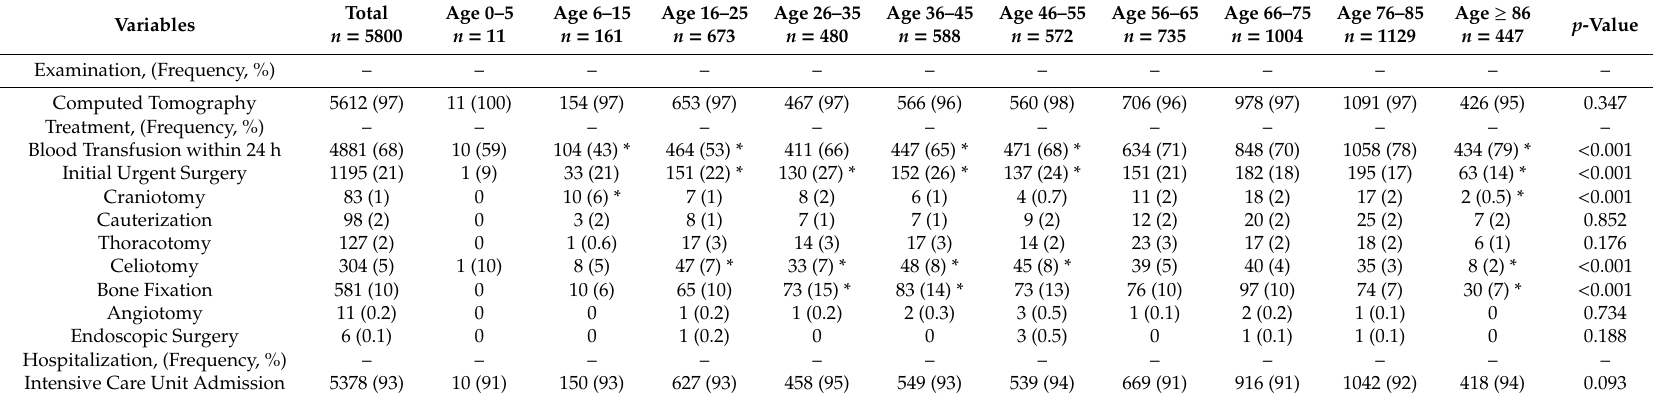
Table 2. Examination, treatment, and hospitalization of trauma patients who underwent transcatheter arterial embolization and differences between the age-stratified